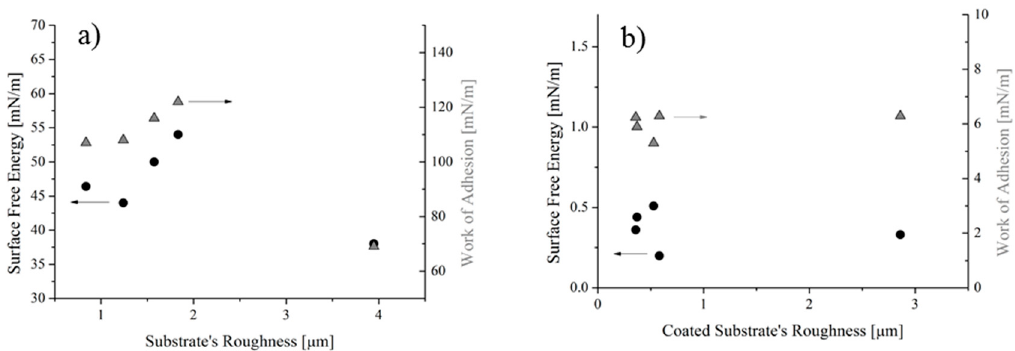
Figure 10. SFE and W A of the uncoated ( a ) and coated ( b ) samples as a function of the roughness. It was found that the solid SFE of the reference samples varies between 44 and 54 mN/m, for roughness values ranging from 0.7 to 2 µm, whereas for roughness of 4 µm the SFE becomes 38 mN/m (Figure 10a). Similarly, the W A varies between 108 and 122 mN/m, assuming a value of 69 mN/m for the sample at 4 µm in roughness. For samples having roughness higher than 4 µm, results cannot be achieved without taking into account the actual surface roughness, e.g., through Equations (12),(13), or more complex relationship, i.e., those described in ref. [33]. Indeed, it was found that roughness higher than 4 µm the Equations’ system (4) did not give a solution, so no intersection of the two curves can be observed in graphs of Figure 11b. On the contrary, for lower values of the contact angles, the Equation system (4) reached solutions, as shown in Figure 11a as an example.